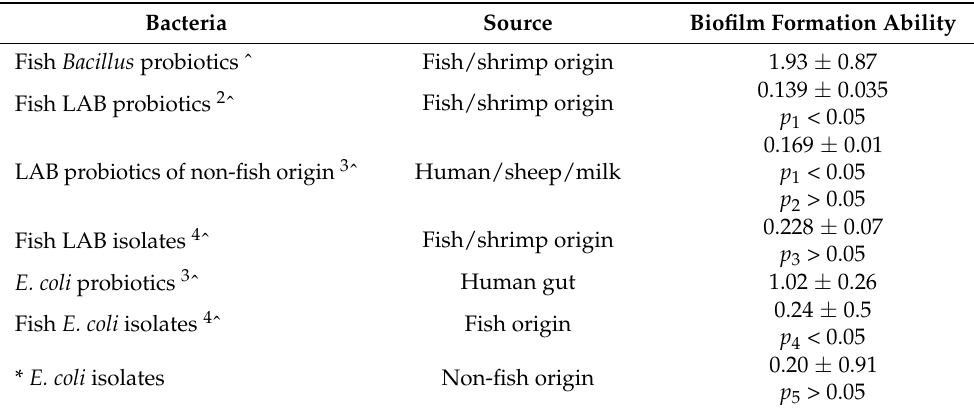
Table 3. Comparative characteristics of biofilm formation ability X of lactic acid bacteria and E. coli isolated from the fish gut microbiota, D average ± standard